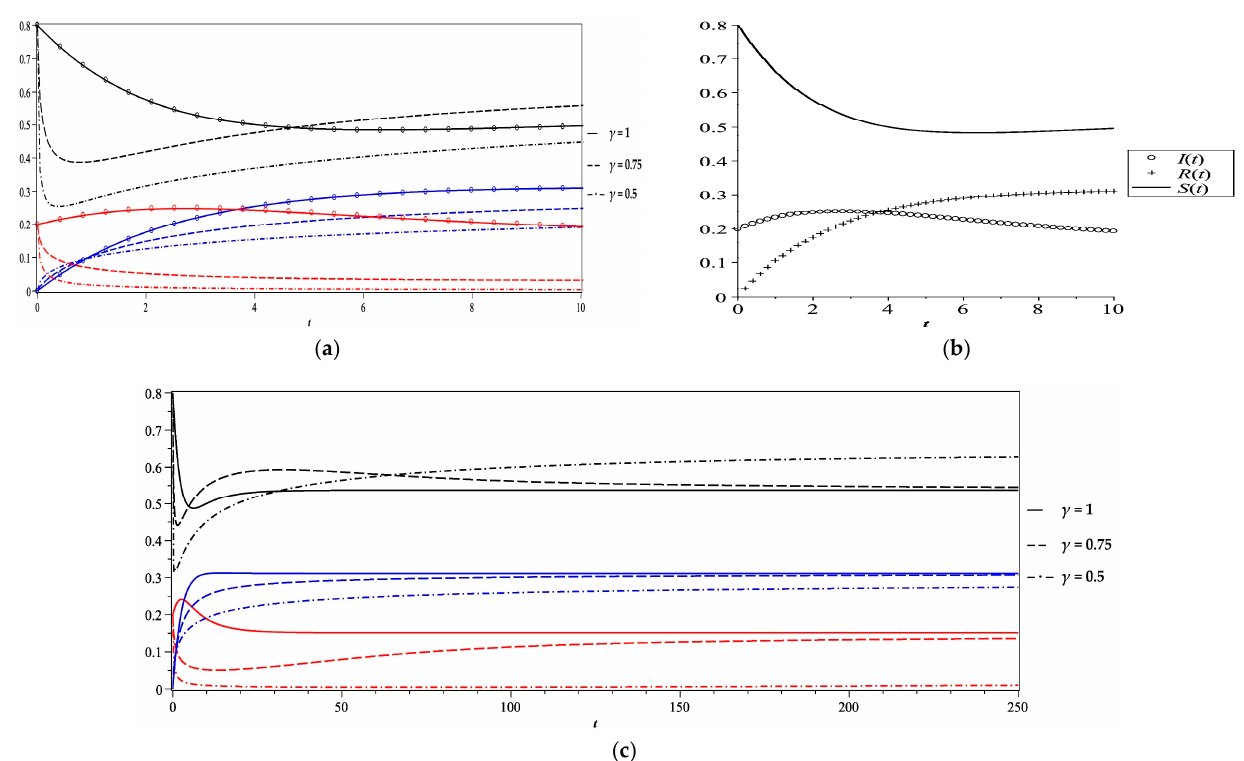
Figure 4. Behavior of various individual fractions ( S in black , I in red and R in blue) versus time for Case 3 at different fractional order values ( a ) till T = 10, ( b ) results of [3] and ( c ) till T = 250.